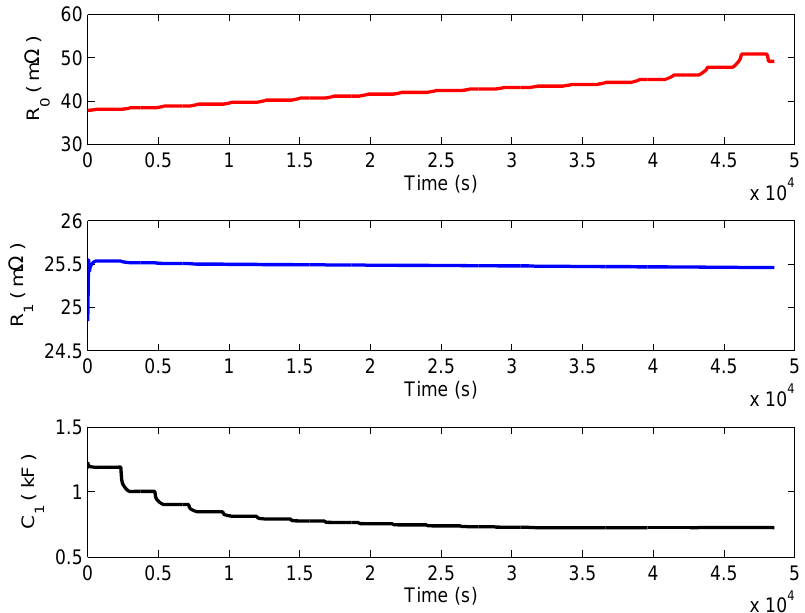
Figure 7. Results of parameters identification using VB-ADEKF in the pulse current discharge